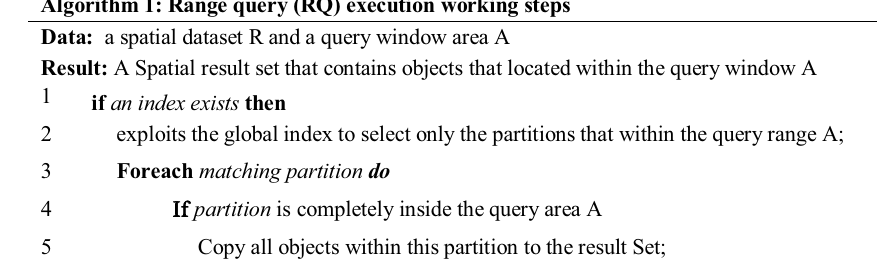
Algorithm 1: Range query (RQ) execution working steps